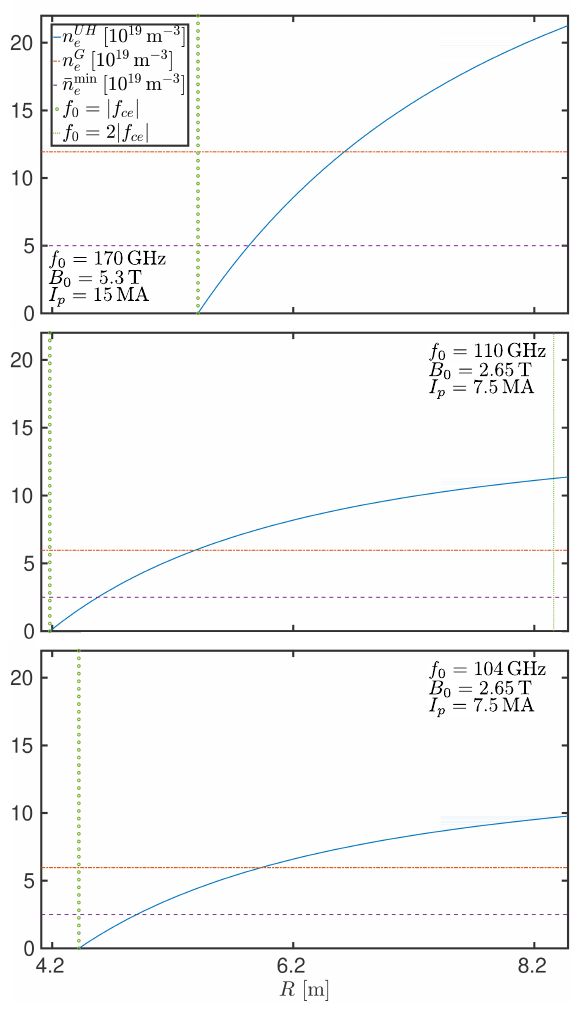
Figure 1. n UH , n G , ¯ n min , f 0 = | f ce | , and f 0 = 2 | f ce | of the O- e e e mode ECRH scenarios planned for ITER [12]. The top panel shows the situation for the full-field scenario ( B 0 = 5 . 3T, I p = 15MA) heated by the main ECRH system, f 0 = 170GHz. The middle and bottom panels show the situations for O-mode ECRH of the half-field scenario ( B 0 = 2 . 65T, I p = 7 . 5MA) with f 0 = 110GHz and f 0 = 104GHz,